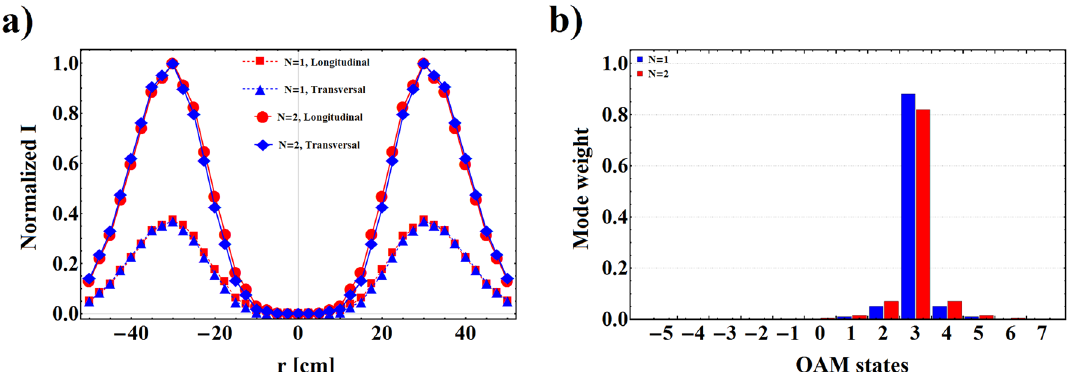
Figure 5. (a) Comparison of normalized transversal and longitudinal intensity distribution of transmitted VB 3 10 11 cm 400 Oe , ℓ 3 , p 7.15 GHz . (b) Comparison of 0 , and ω 1 and N 2 , with n e for N , H 0 − = = = = = = = 1 and N 2 , with the other parameters same as part (a) . transmitted topological charge mode weight for N = =